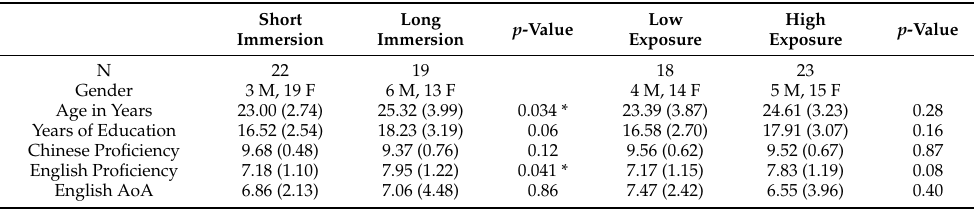
Table 3. Language background of short vs. long immersion and low vs. high exposure groups. Short p -Value Immersion